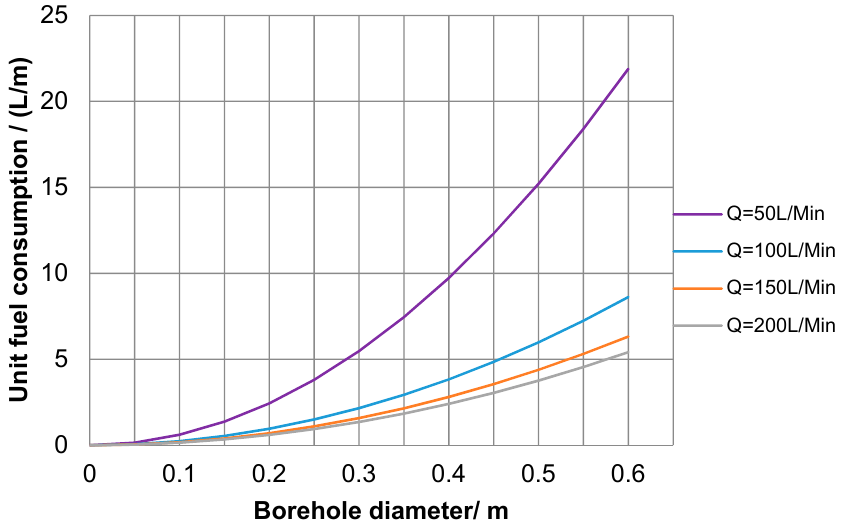
Figure 9. Fuel consumption (diesel) vs. mean borehole diameter at different target depths and flow rates ( b = 11 mm, d h = 38 mm, k = 0.3 J s − 1 m − 1 K − 1 , T i = − 20 °C, and C w = 4190 J kg − 1 K − 1 )